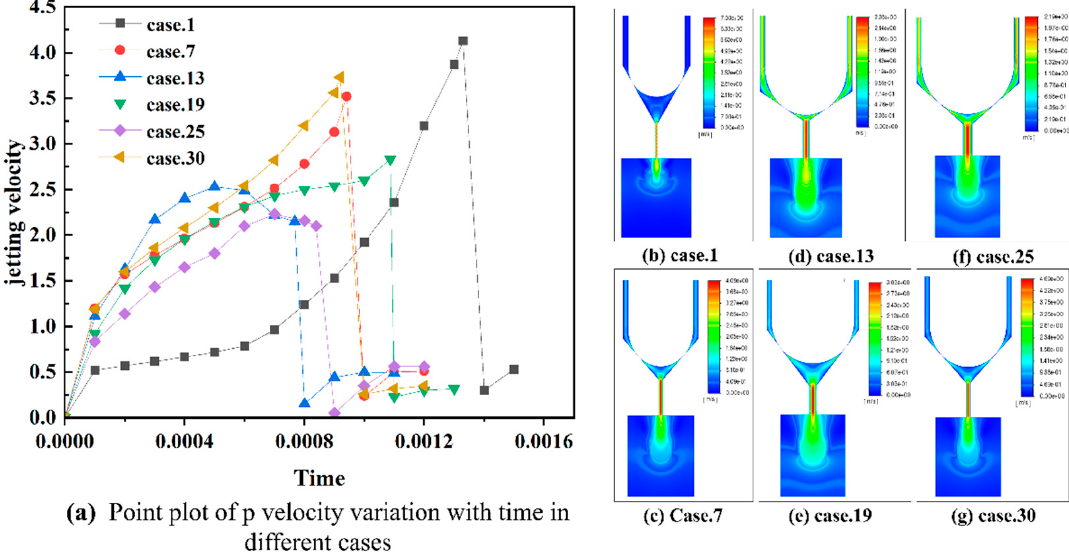
Figure 6. ( a – g ) Variation in jetting velocity with time, for different cases.